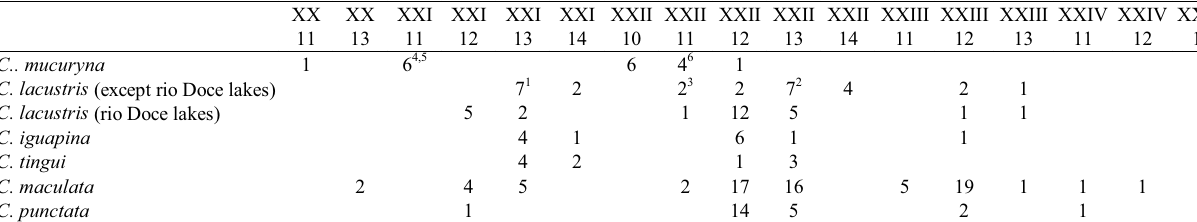
Table 5. Dorsal fin count frequencies in species of Crenicichla from southeastern Brazil. 1 MNHN A9501 (126.0 mm), syntype of C. lacustris ; 2 FMNH 54155 (117.0 mm); holotype of C. dorsocellata ; 3 MZUSP 1781 (150.0 mm), paratype of C. biocellata ; 4 lectotype of C. mucuryna (113.3 mm); 5 MZUSP 5385), paralectotype of C. mucuryna (69.0 mm); 6 MZUSP 5386 (110.0 mm), paralectotype of C. mucuryna .